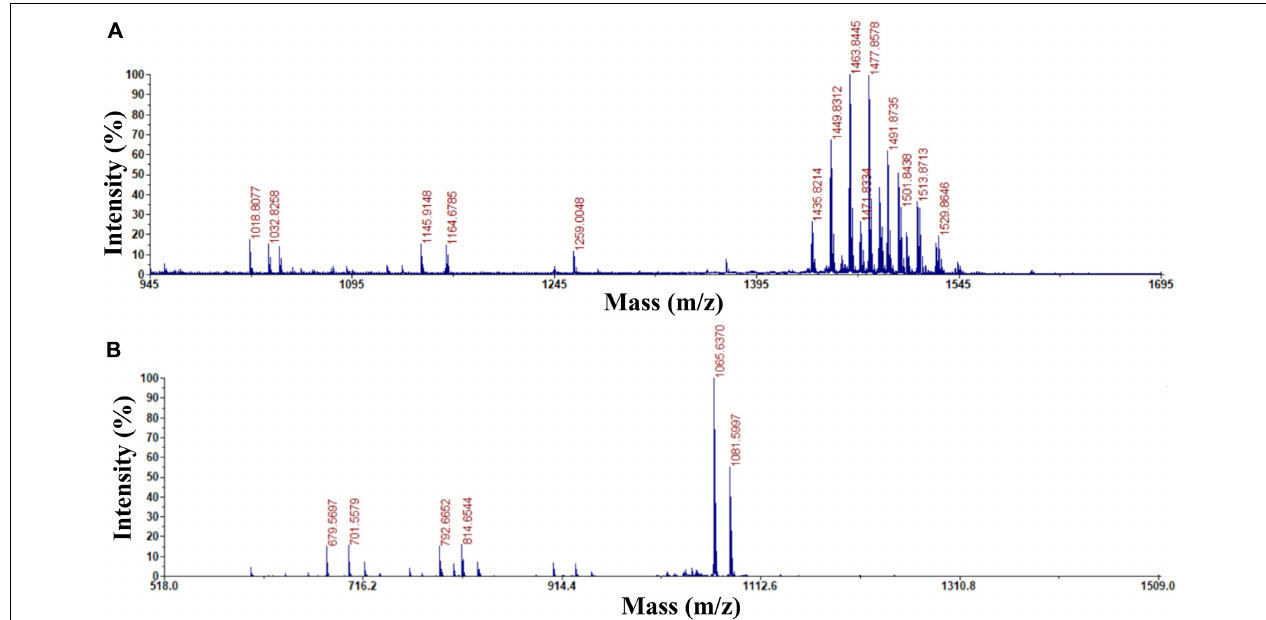
FIGURE 1 | Determination of the purity and ingredients of fengycin and C14 iturin A by matrix assisted laser desorption ionization-time of flight mass spectrometry. (A) The purity and ingredient analysis for the eluent with a retention time of 2.736 min isolated by HPLC and identified as fengycin; (B) the purity and ingredient analysis for the eluent with a retention time of 11.218 min isolated by HPLC and identified as C14 iturin A.